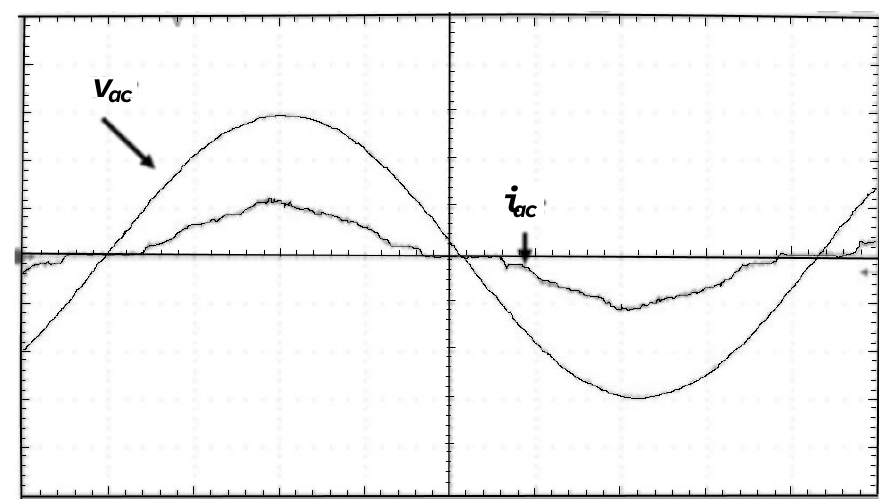
Figure 15. Main line current i ac (200 mA/div) and voltage v ac (60 V/div).